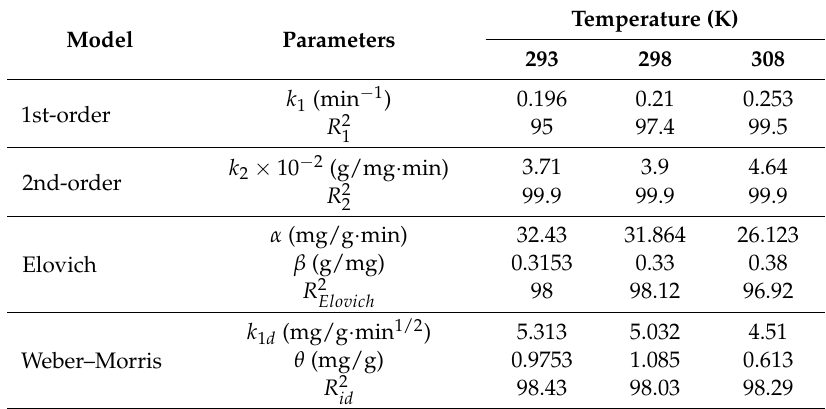
Table 5. Rate parameters at different temperatures (condition: Initial concentration of Sr 2+ in solution is 220 mg/L at pH 6.5).